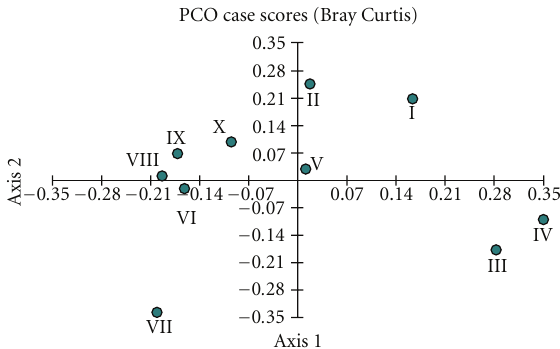
Figure 5: PCO analysis of the sites located in the northern and southern portions of Serra da Bodoquena using the Bray-Curtis dissimilarity index (eigenvalues: 0001).